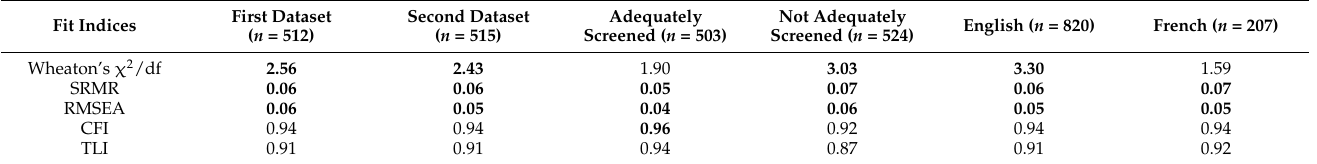
Table 3. CFA model fit indices for the HPV Testing Attitudes and Beliefs Scale (20 items).